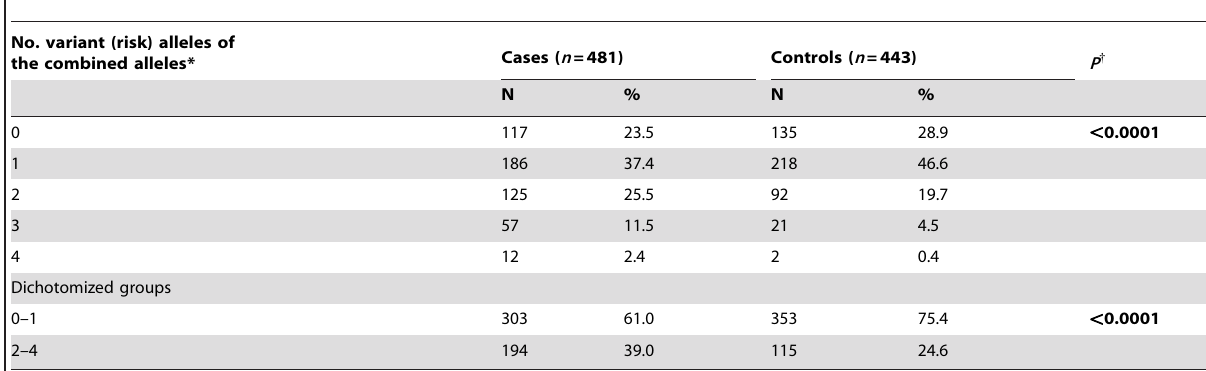
Table 6. Distributions of the ADAM33 combined genotypes among cases and controls.